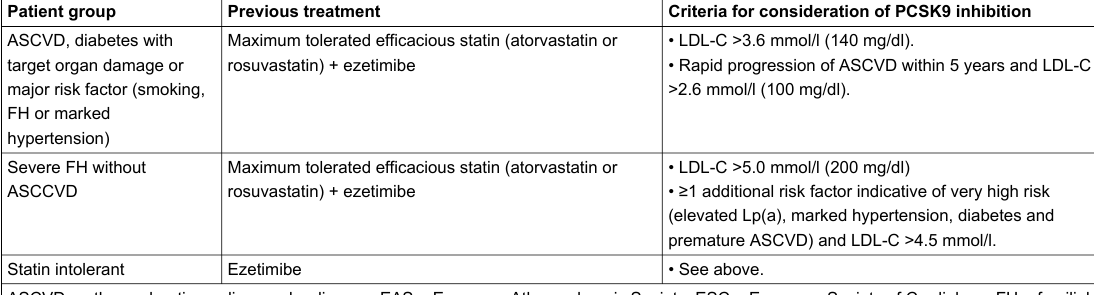
Table 2: Very high-risk patient groups for whom PCSK9 inhibitors may be considered, according to the ESC/EAS panel. Patient